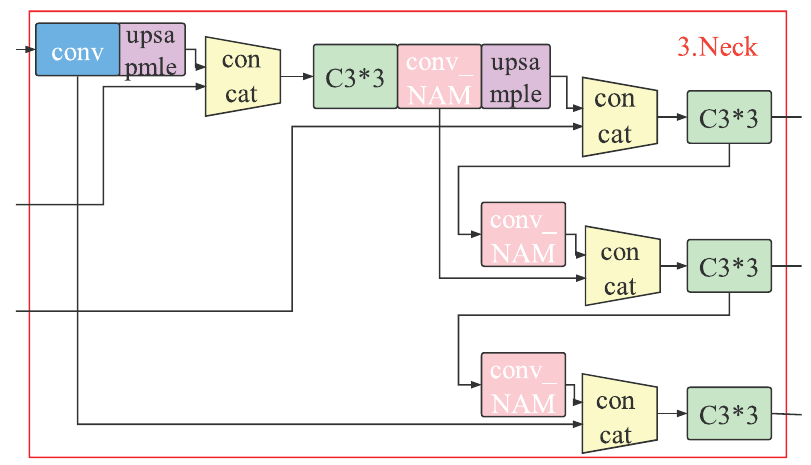
Figure 8. The Neck of the YOLOv5-NAM network